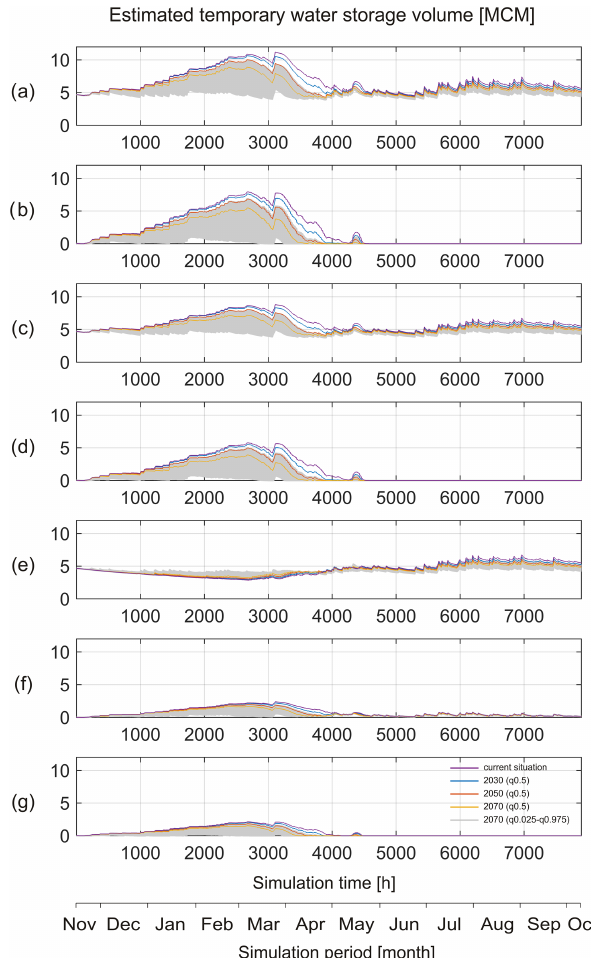
Figure 8. Impacts of the median climate scenarios ( q 0 . 5) for years 2030, 2050 and 2070 as well as the uncertain climate scenarios (1000 random sampled combinations) for 2070 on (a) the simulated water storage of the whole catchment, (b) the simulated snow stor- age of the whole catchment, (c) the simulated water storage of the karst area, (d) the simulated snow storage of the karst area, (e) the simulated water storage of the karst aquifer, (f) the simulated water storage of the non-karst area and (g) the simulated snow storage of the non-karst